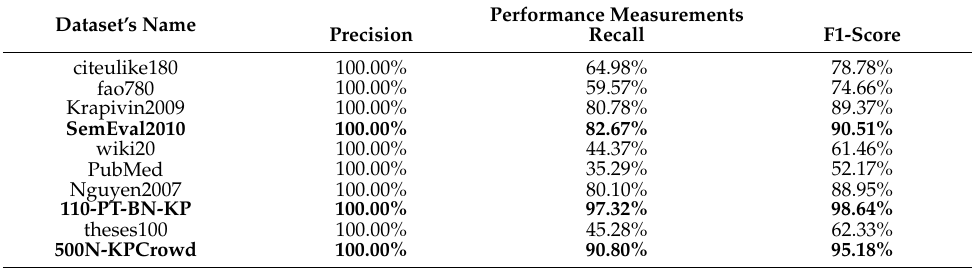
Table 2. Performance comparison of all datasets for finding a better